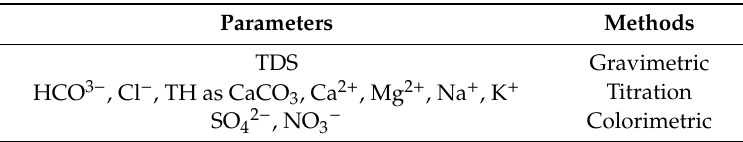
Table 2. Hydrochemical parameters and methods of analysis conducted in the laboratory at the Sulaimani Directorate of Environment. TDS: total dissolved